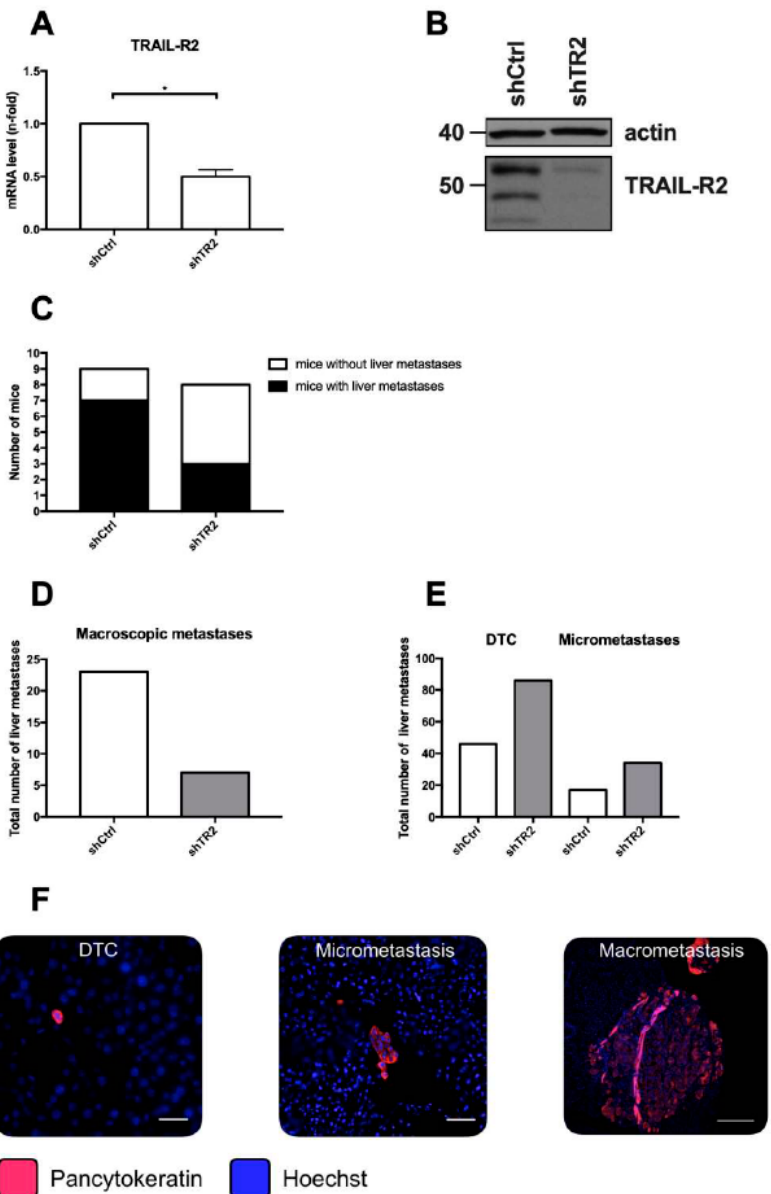
Figure 1. Knockdown of TRAIL-R2 in PancTu-I cells leads to reduced macroscopic liver metastases but higher numbers of small metastatic lesions after primary tumor resection in vivo. ( A ) ShRNA-mediated knockdown of TRAIL-R2 in PancTu-1 cells was verified on mRNA and protein level by ( A ) qRT-PCR or ( B ) Western blot. ( A ) The mRNA level of TRAIL-R2 was normalized to GAPDH mRNA level in control transfected (shCtrl) or TRAIL-R2 knockdown (shTR2) PancTu-I cells. Data present n-fold mRNA level of shCtrl PancTu-I cells. ( B ) A representative western blot. Actin levels were used as loading control. PancTu-I shCtrl or PancTu-I shTR2 cells were orthotopically inoculated in Severe Combined ImmunoDeficiency (SCID) beige mice and after 10 days primary tumors were resected by subtotal pancreatectomy. At 26 days post-surgery, metastatic burden in livers was assessed ( C , D ) macroscopically and ( E ) by immunofluorescence pan-cytokeratin staining of 3 tissue slides per animal. Disseminated tumor cells (DTC) and micrometastases were determined by counting Hoechst stained nuclei of pan-cytokeratin + tumor cells. ( F ) Representative images of disseminated tumor cells (DTC; 1–10 cells), micrometastasis (10–100 cells), and macrometastasis ( > 100 cells) are shown. Scale bars 25 µ m (left), 50 µ m (middle), 200 µ m (right). Data represent mean ± SEM or absolute numbers of 9 (PancTu-I shCtrl) or 8 (PancTu-I shTR2) animals /